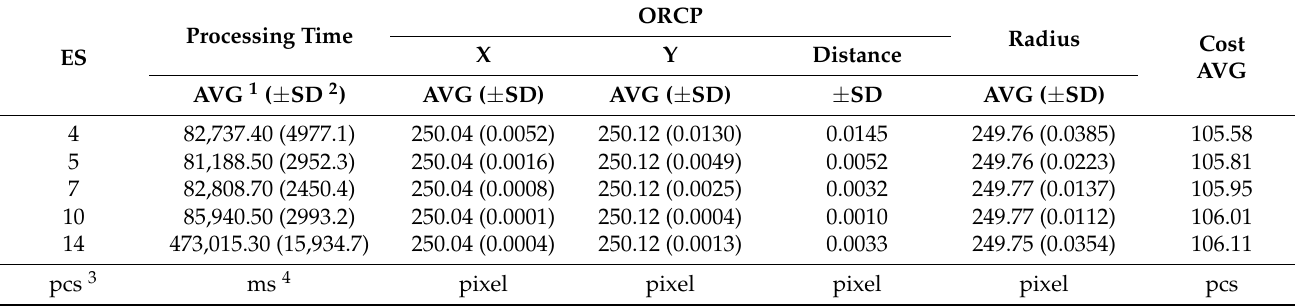
Table 1. Performance of HPOM estimation according to ES.